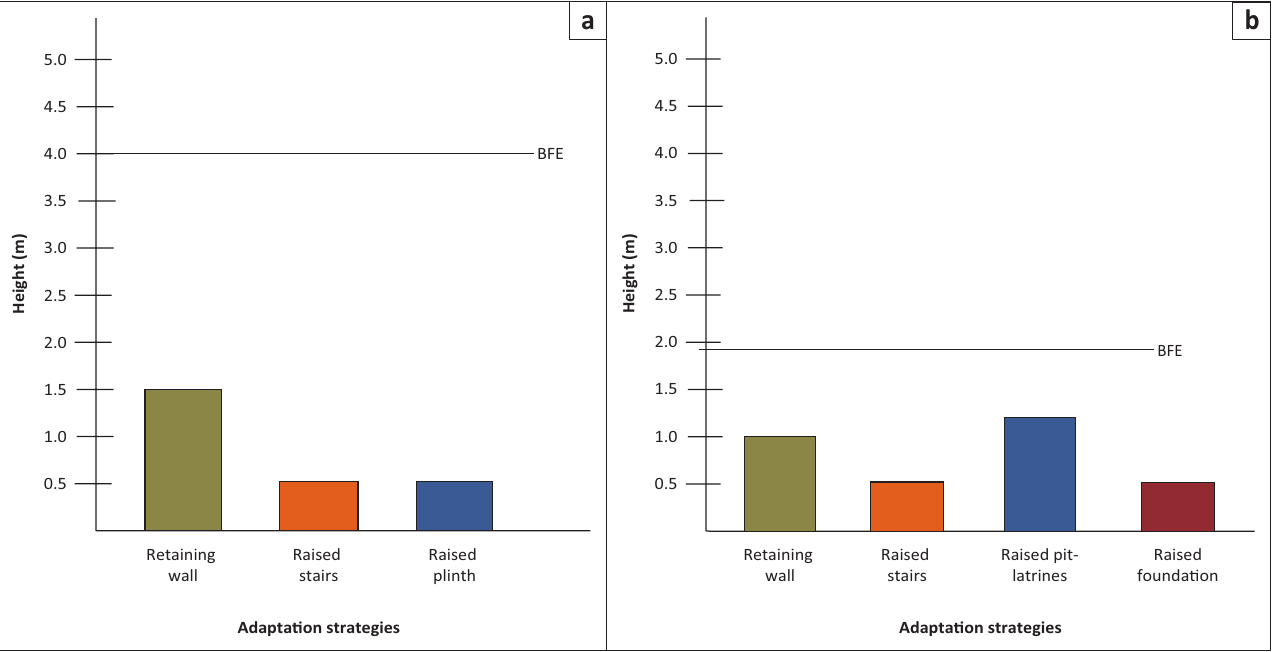
FIGURE 5: Comparison of the height of flood protection structures relative to base flood elevation in, (a) Sangkrah and (b) Keko Machungwa informal